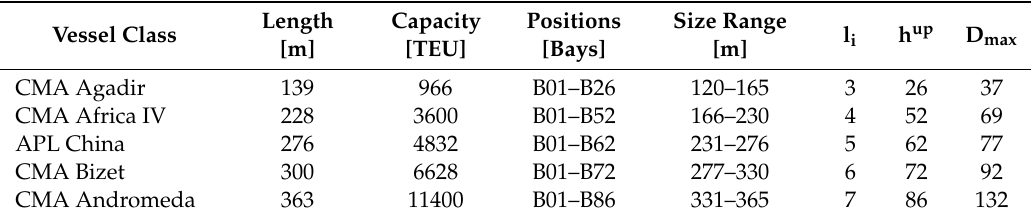
Table 1. Representative classes of container ships that maintain liner service in Adriatic